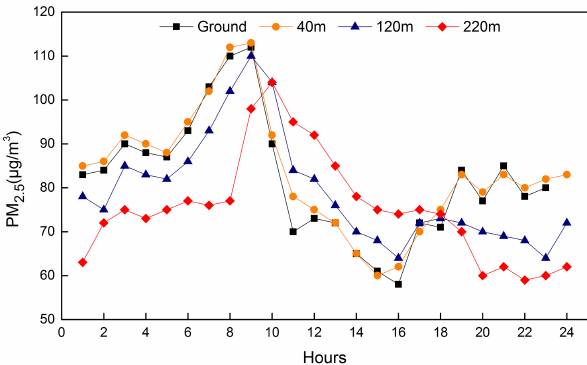
Figure 5. Vertical diurnal variation of PM 2 . 5 mass concentrations during the period from 1 July to 30 September 2009.